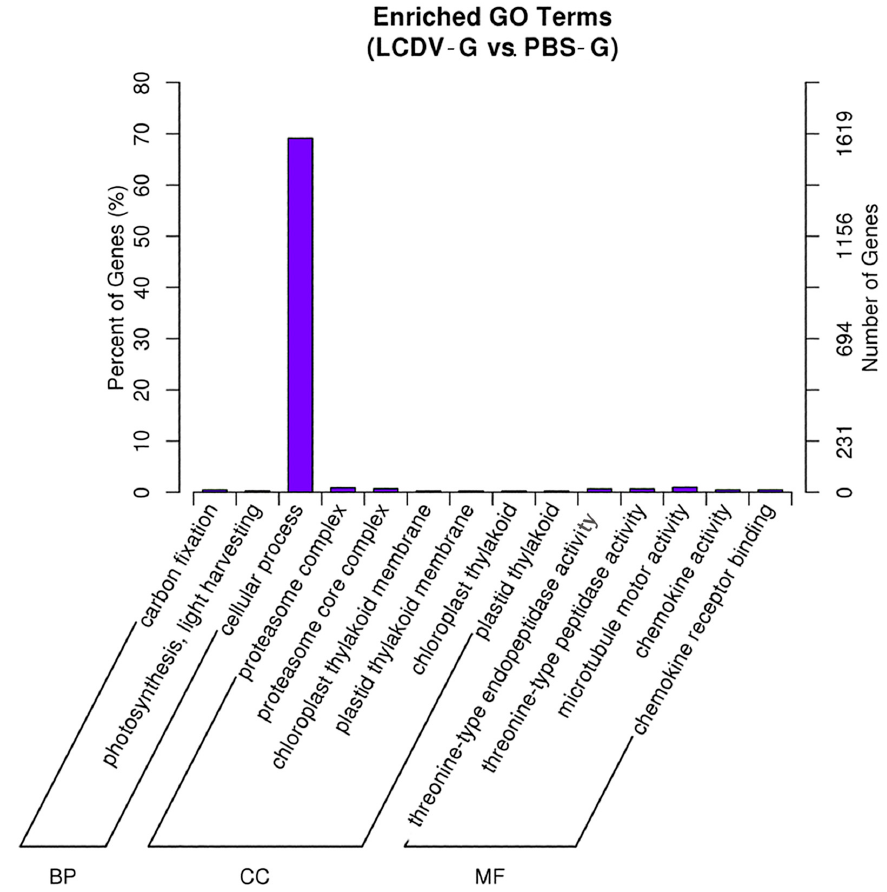
Figure 6. Enriched GO Terms of DEGs. X -axis, three main categories: biological process (BP), cellular component (CC), and molecular function (MF); Y -axis, number/percent DEGs of a term in the total annotated DEGs.